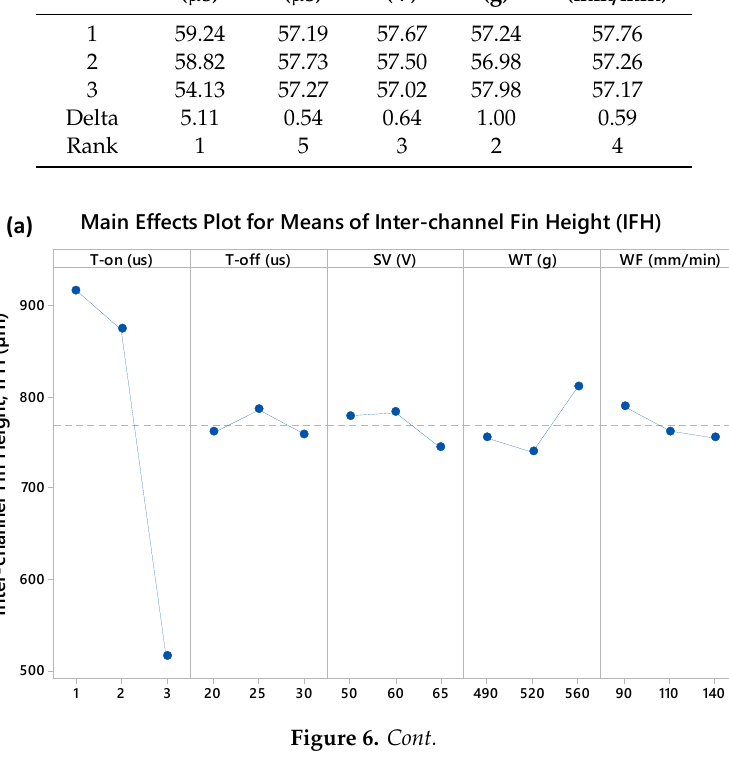
Figure 6. Parametric effects on inter-channel fin thickness (IFH): ( a ) main effects plot and ( b ) interaction plot. Table 7. S/N ratio analysis of IFH (Larger is better).